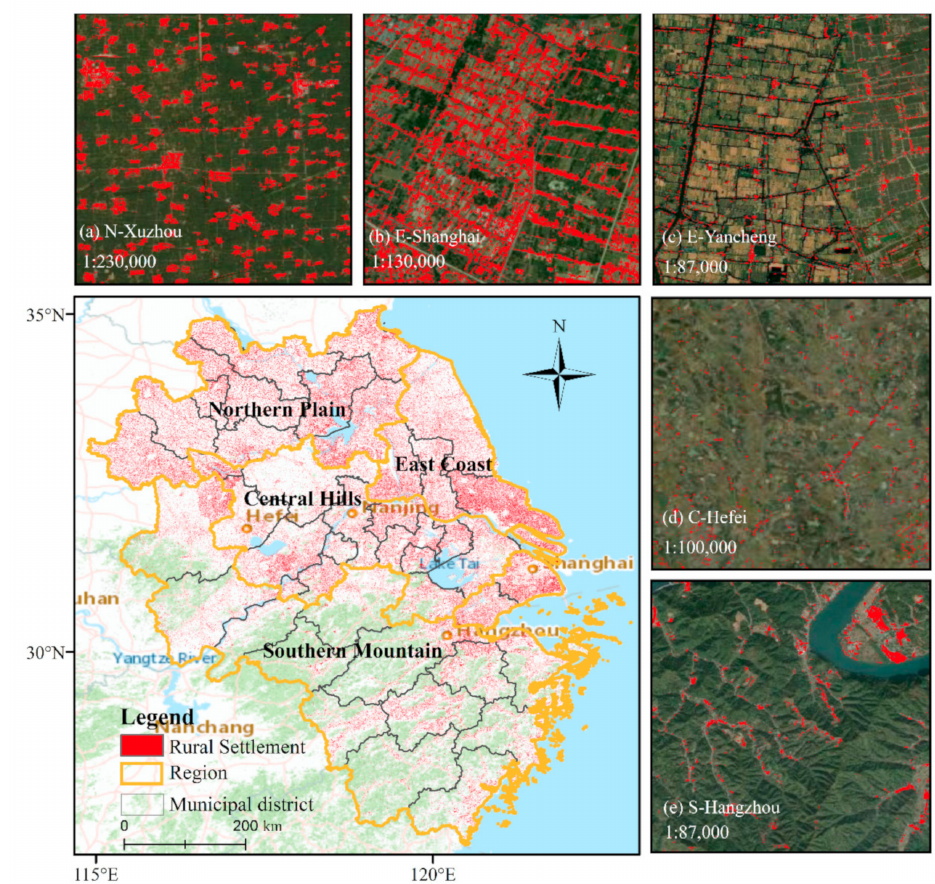
Figure 7. Spatial distribution of rural settlements in the Yangtze River Delta. N-Xuzhou, E-Shanghai, E-Yancheng, C-Hefei, and S-Hangzhou represent Xuzhou in Northern Plains, Shanghai in East Coast, Yancheng in East Coast, Hefei in Central Hills, and Hangzhou in Southern Mountain, respectively. The five subplots demonstrate the representative rural settlements of the municipal